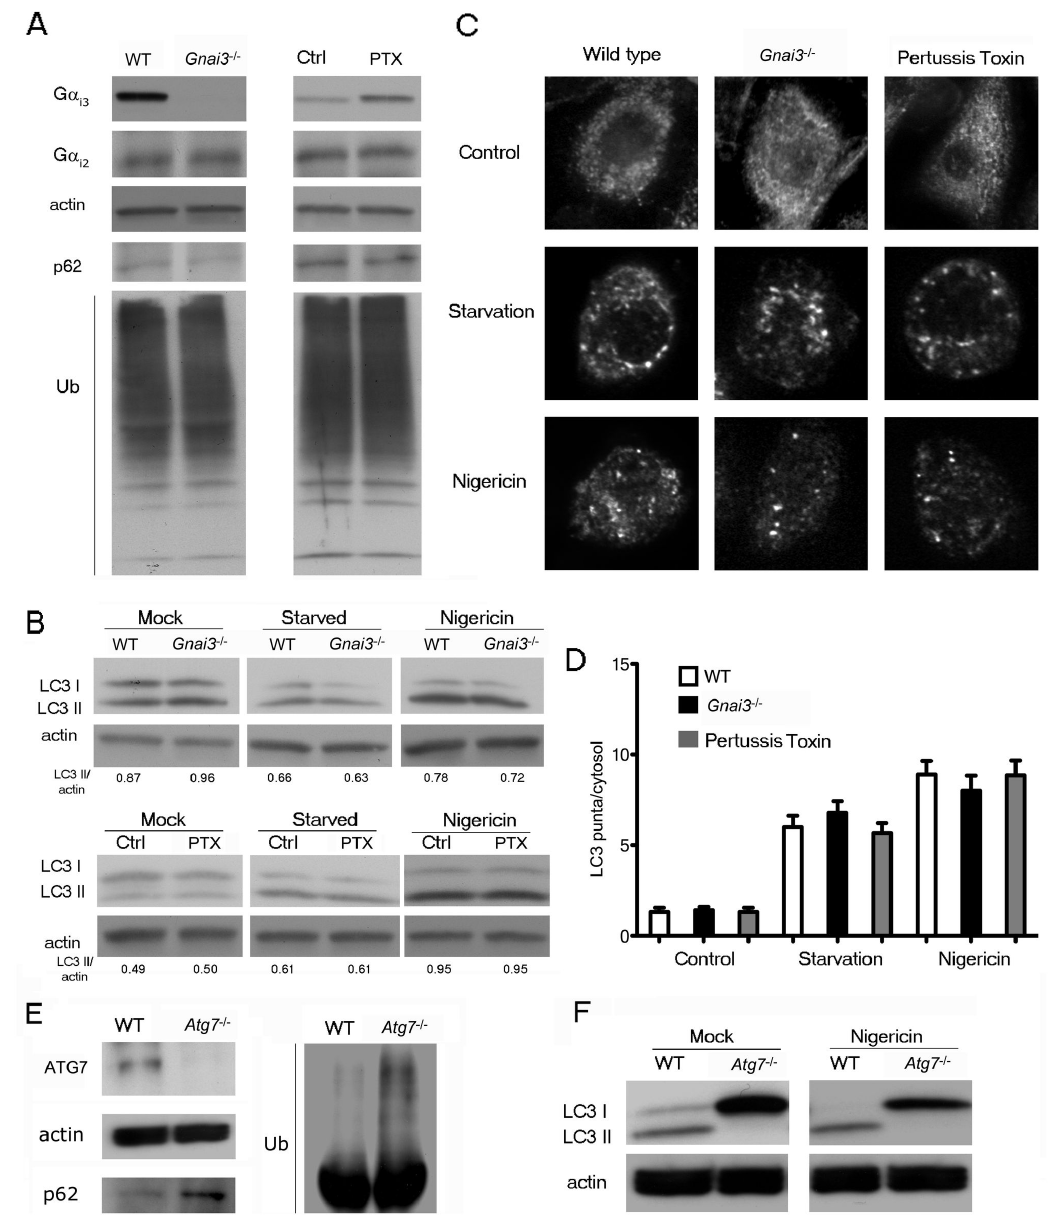
Figure 1. The lack of Gα or PTX treatment does not affect autophagy induction in primary mouse macrophages. ( A ) i3 Immunoblot analysis of cell lysates from BMDM prepared from wild type mice; Gnai3 -/- mice; or wild type mice pre-exposed to PTX (200 ng/ml for 2h), or not, to assess the steady state levels of Gα , Gα , p62 and ubiquitin proteins. ( B ) Immunoblot analysis of cell i3 i2 lysates from BMDM prepared from wild type mice; Gnai3 -/- mice; or wild type mice pre-exposed to PTX as above, or not, either not further manipulated, starved (HBSS for 1h with 100 nM Bafilomycin A1), or treated with nigericin (4 µM for 4h) to assess LC3-II/actin band ratios. ( C ) Endogenous LC3 immunocytochemistry of BMDM from wild type mice, Gnai3 -/- mice, or from wild type mice pre- exposed to PTX (200 ng/ml for 2h) either not further manipulated, starved (HBSS for 1h with 100 nM Bafilomycin A1), or treated with nigericin (4 µM for 4h). Representative images are shown for each condition. ( D ) Quantification of endogenous LC3 dots performed by fluorescence microscopy for at least 70-100 cells from experiment shown in part C. Data represents the mean LC3 puncta per cytosol ± SEM for three independent experiments for each condition. ( E ) Immunoblot analysis of cell lysates from BMDM prepared from wild type mice and Atg7 -/- mice to assess the steady state levels of p62 and ubiquitin proteins. ( F ) Immunoblot analysis of cell lysates from BMDM prepared from wild type mice and Atg7 -/- deficient mice, either not further manipulated, or treated with nigericin (4 µM for 4h) to assess LC3-II/actin band ratios. doi: 10.1371/journal.pone.0081886.g001 PLOS ONE |